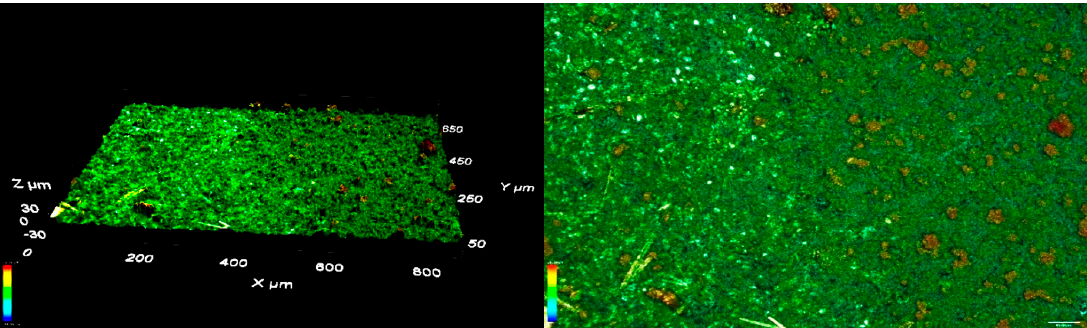
Figure 10. Three ‐ dimensional (3D) and 2D images acquired by 3D profilometer on a sample portion. The right side underlying the bubble during immersion.